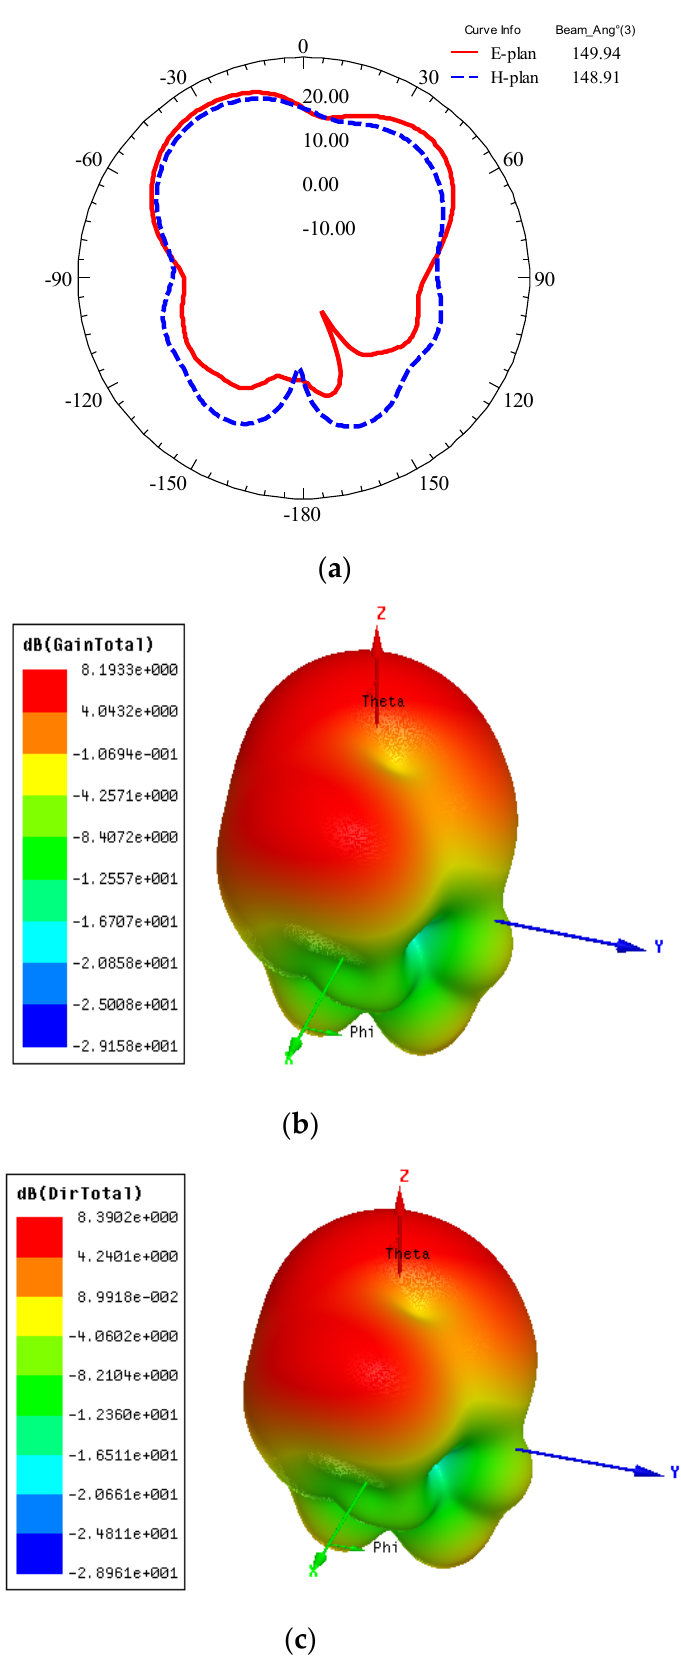
Figure 24. 2D radiation pattern, 3D gain, and total directivity of proposed full satellite at 2450 MHz: ( a ) E- and H-fields at 2450 MHz: phi = 0°; 90°; ( b ) 3D gain at 2450 MHz; ( c ) 3D directivity at 2450 MHz.